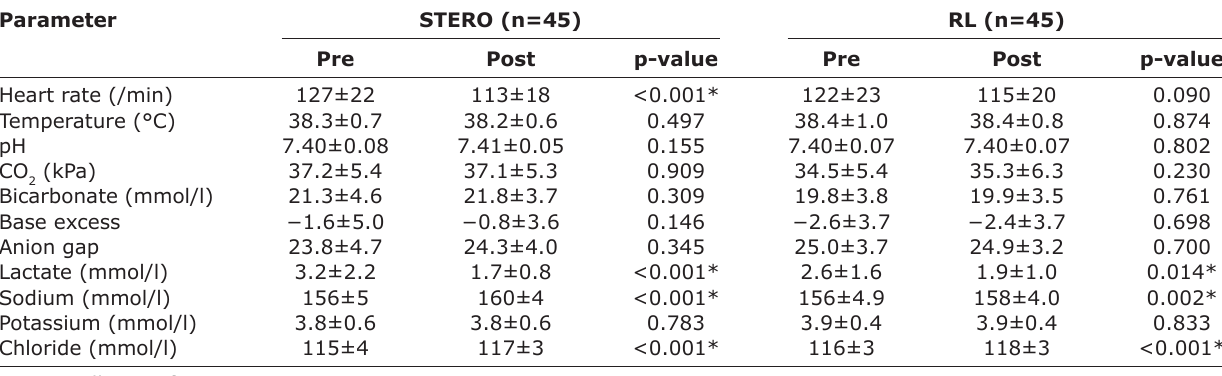
Table-3: Vital parameters, venous blood gas values, lactate, and electrolytes before (pre) and after (post) rehydration with acetated (STERO) or lactated (RL) rehydration fluids in 90 dogs compared with